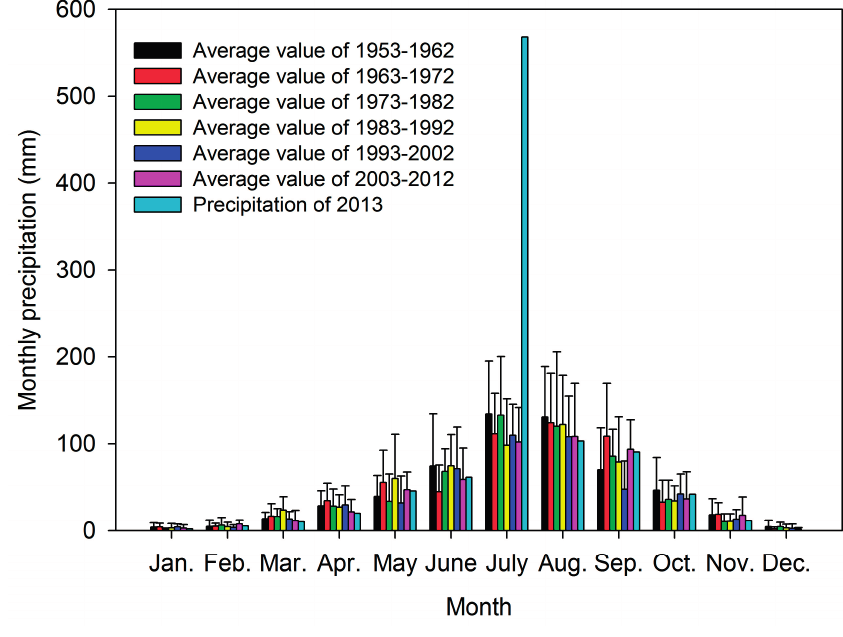
Figure 3. Monthly rainfall distribution in